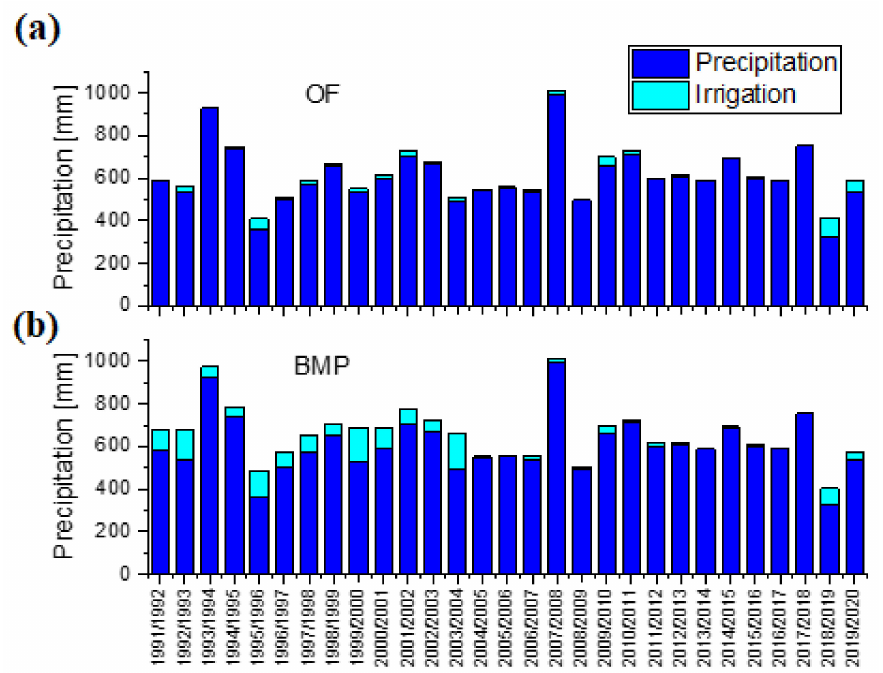
Figure 1. Water supply (precipitation and irrigation) of Organic Farming (OF ( a )) and Best Manage- ment Practice (BMP ( b )) management types during the study period